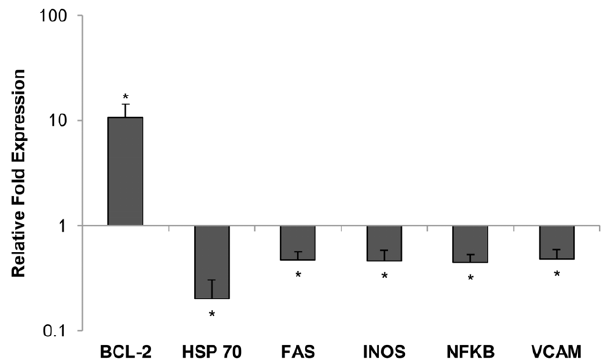
Figure 8. Inflammatory gene transcript expression in liver tissue of FTY720 relative to the control group. Mean value of relative fold expression is depicted on a logarithmic scale. * indicates p , 0.05 compared to control group.